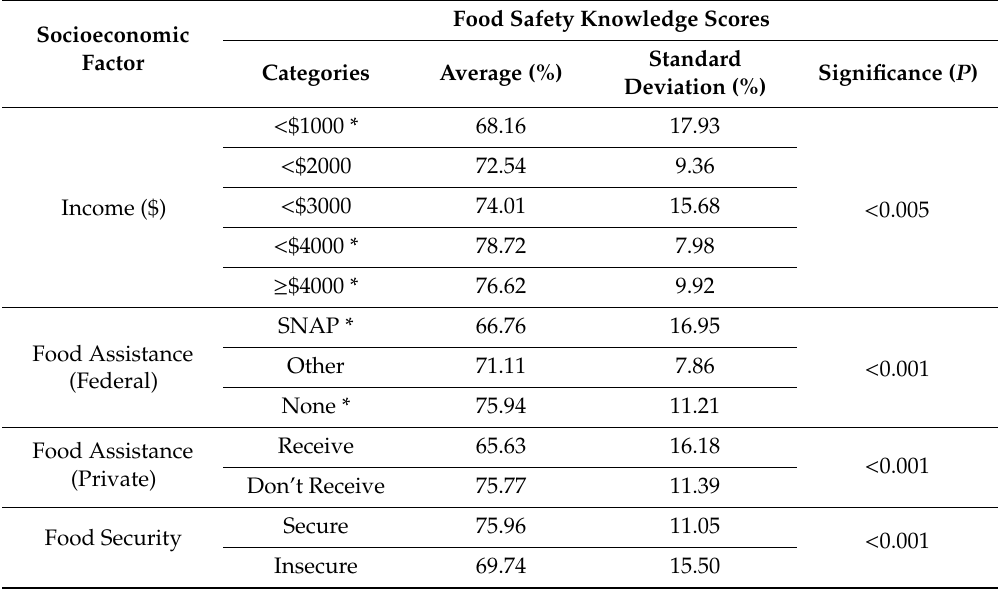
Table 4. Food safety knowledge across socioeconomic groups of cancer